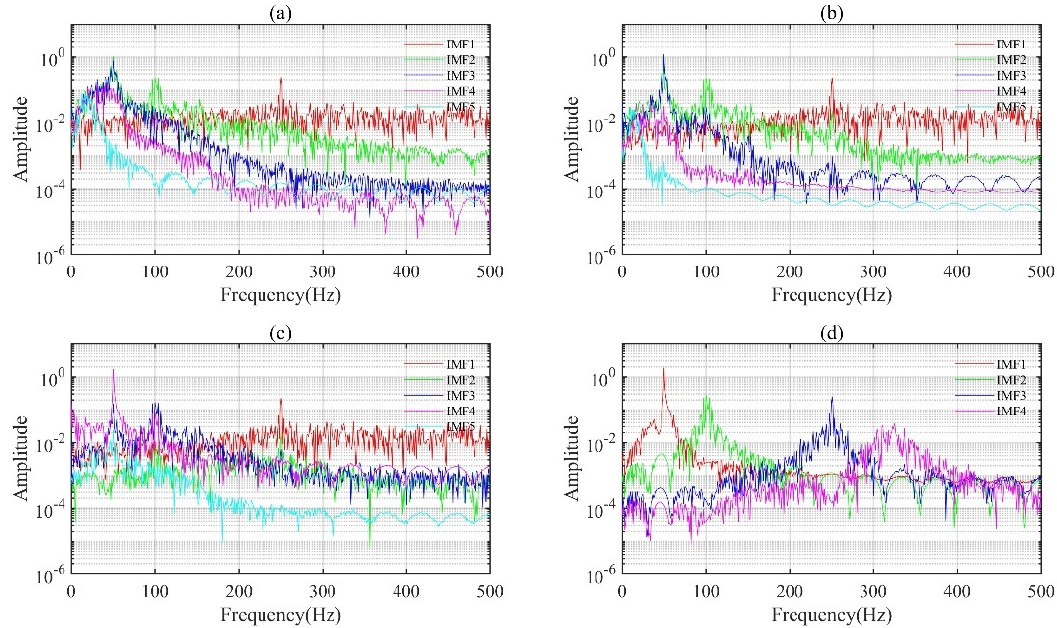
Figure 1. The frequency spectrums of different IMFs after decomposition by different methods: ( a ) EMD, ( b ) EEMD, ( c ) CEEMD, and ( d ) VMD.